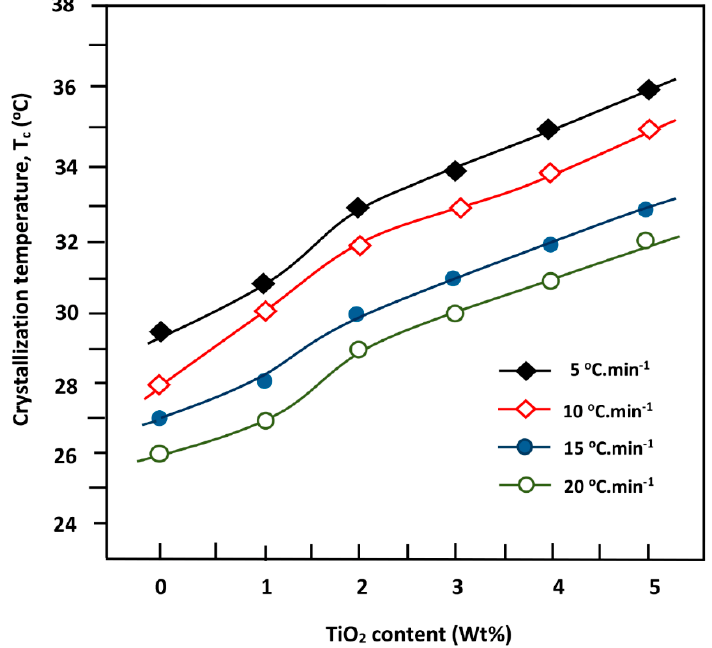
Figure 7. Variation of the maximum crystallization temperature T c of pure PDVL and PDVL/TiO 2 nanocomposites versus composition.